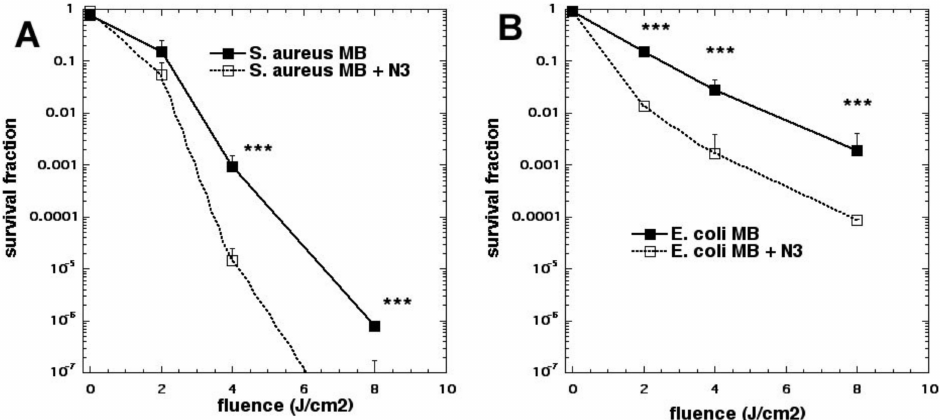
Figure 3. Paradoxical potentiation of methylene blue (MB) aPDI by addition of sodium azide.